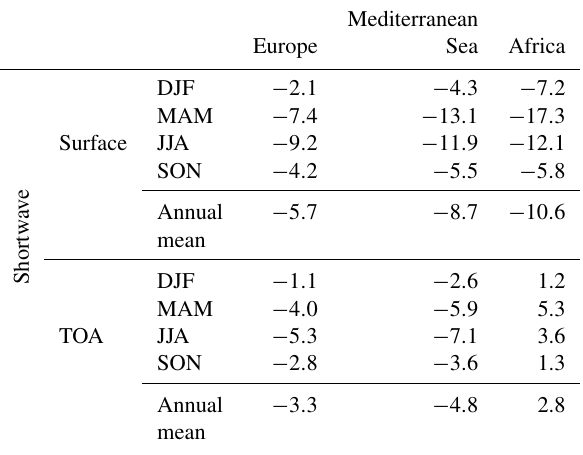
Table 3. Mean SW DRF (Wm − 2 ) of all aerosols over the period 1971–2000 at the surface and at the TOA over Europe, Mediter- ranean Sea and